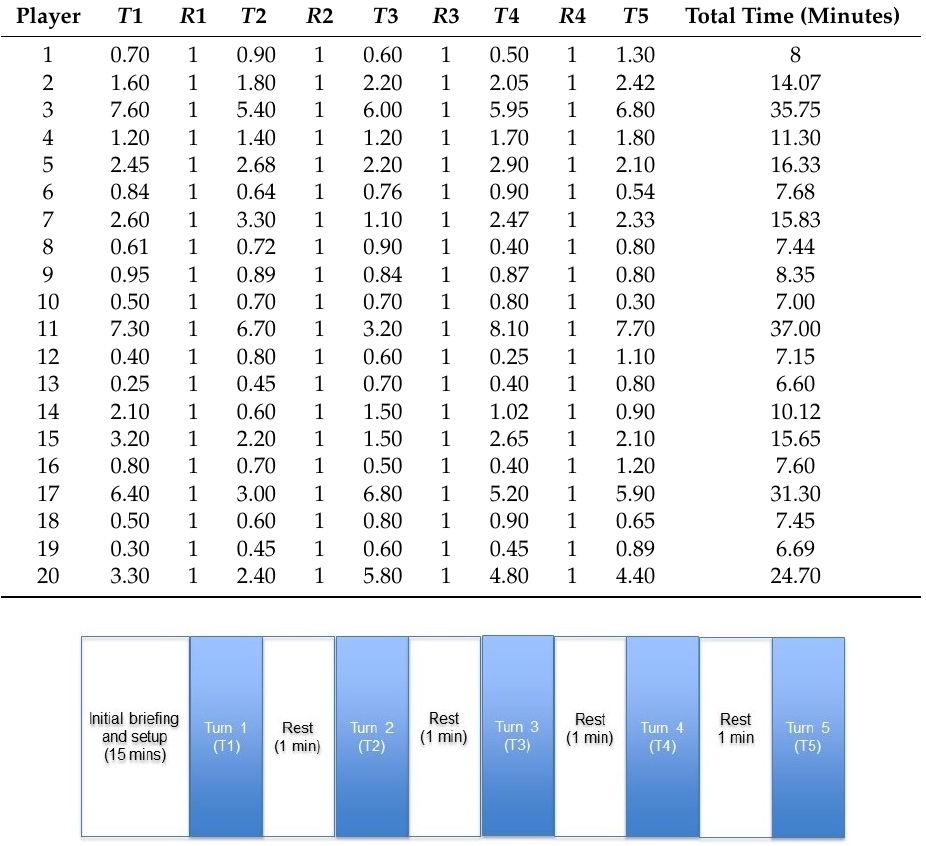
Figure 3. The experimental procedure used to record the data of game